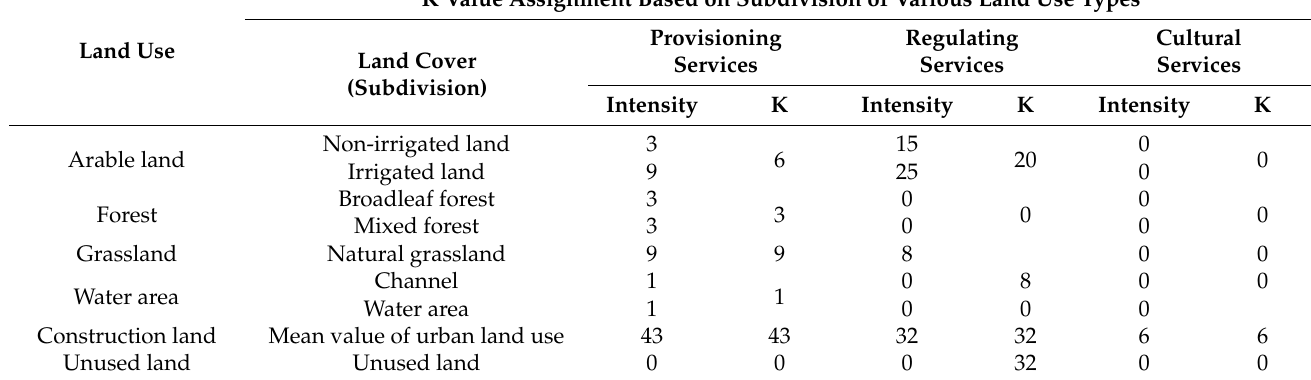
Table 3. The intensity and K value of ecosystem services demand of various land use